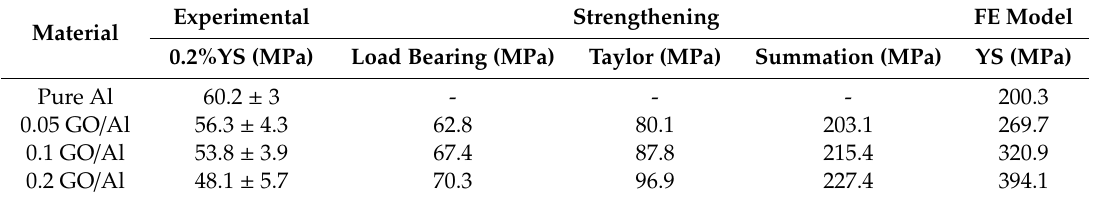
Table 2. Comparison of yield stress obtained from experimental, analytical, and FE model.